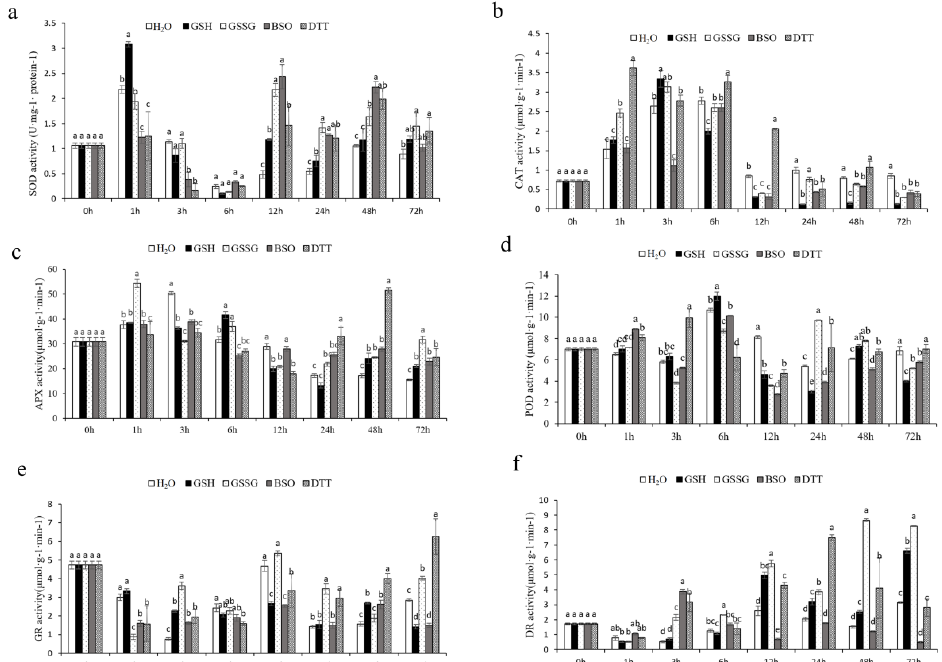
Figure 7. ( a ) Superoxide dismutase (SOD) activity, ( b ) catalase (CAT) activity, ( c ) ascorbate peroxidase (APX) activity, ( d ) peroxidase (POD) activity, ( e ) glutathione reductase (GR) activity, and ( f ) dehydroascorbate reductase (DHAR) activity in pakchoi leaves treated with GSH (100 µ M) or GSSG (100 µ M) or BSO (1 mM) or DTT(5 mM). Data are the means of three biological replicates ( ± SD) shown by vertical error bars. Different letters indicate significant differences according to Tukey’s test at 0.05% level. As part of the analysis of the potential interrelationship between GSH and antioxidant signaling, enzymatic components of the ascorbate–glutathione cycle were also studied. Figure 7 shows the activity of APX, DHAR, and GR. The performance of leaf APX activity increased 24 h after all treatments, especially at 48 h, DTT spraying uploaded the APX activity to 198%. GSSG-treated plants also showed an increase (103%) at 72 h. In response to GSSG, BSO, and DTT treatments, the leaf DHAR activity uptick at 3 h, except for GSH treatment. Treatment with GSH, GSSG, BSO, and DTT caused significant increases in enzyme activity of GR at 3 h, with GR level increasing by 197%, 376%, 114%,157% in the leaf respectively.